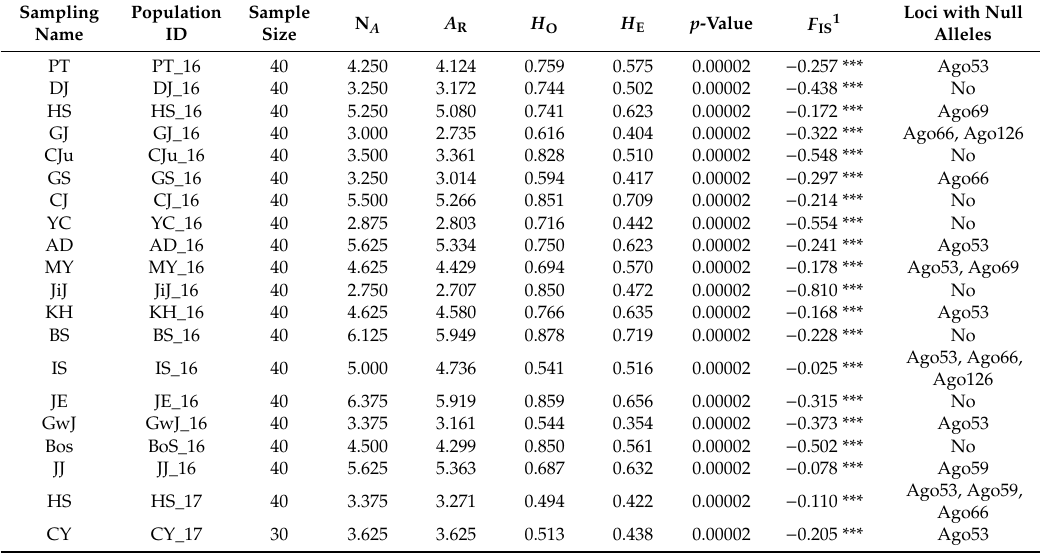
Table 1. Genetic variation estimates of geographic population of Aphis gossypii . Number of alleles coe ffi cient ( F IS ), probability ( p -value) of being in Hardy–Weinberg equilibrium (HWE), and loci